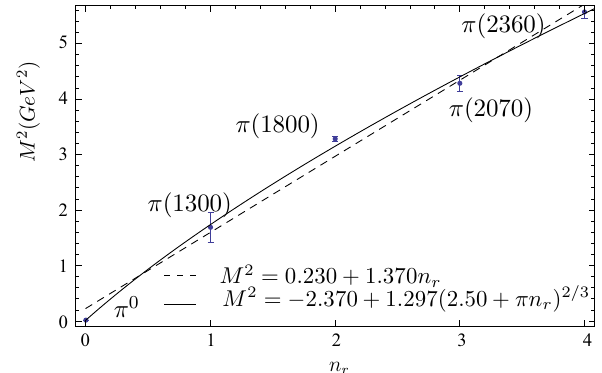
Fig. 1 The radial Regge trajectory of π